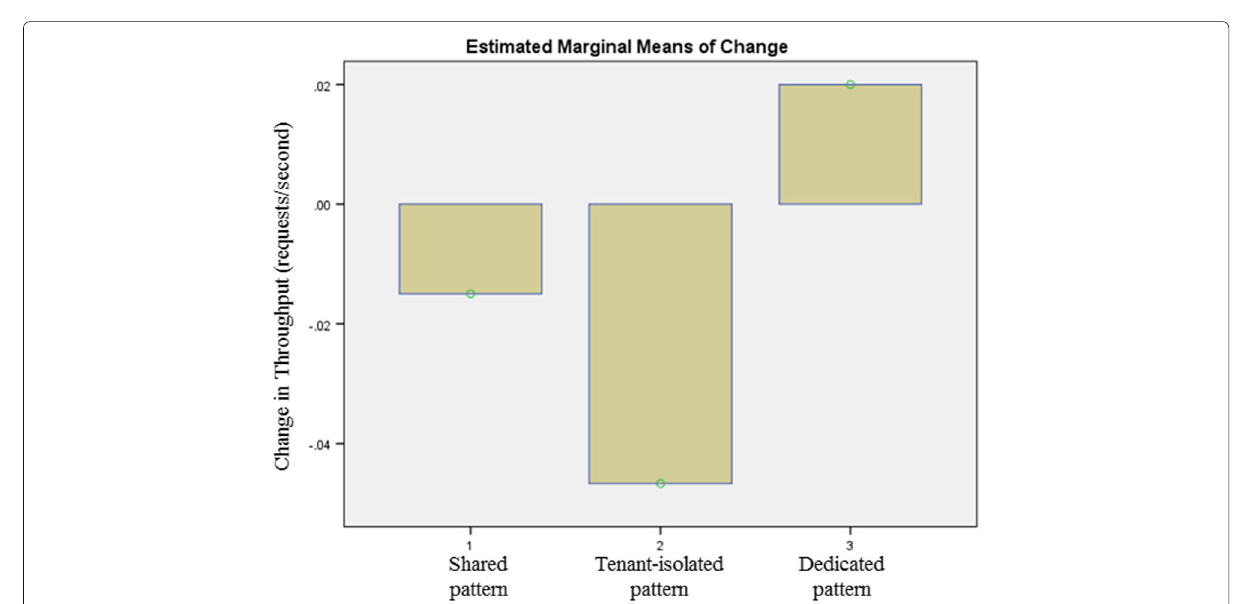
Fig. 24 Changes in Throughput